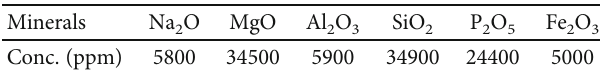
Table 2: XRF analysis of SpLAC.